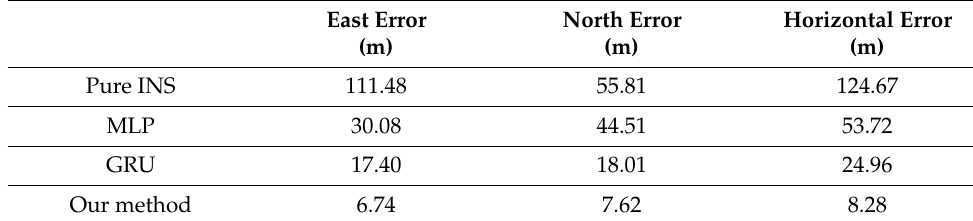
Figure 19. The trajectories of 300 s outage of Experiment 1. Table 4. Maximum position error of 300 s outage of Experiment 1.